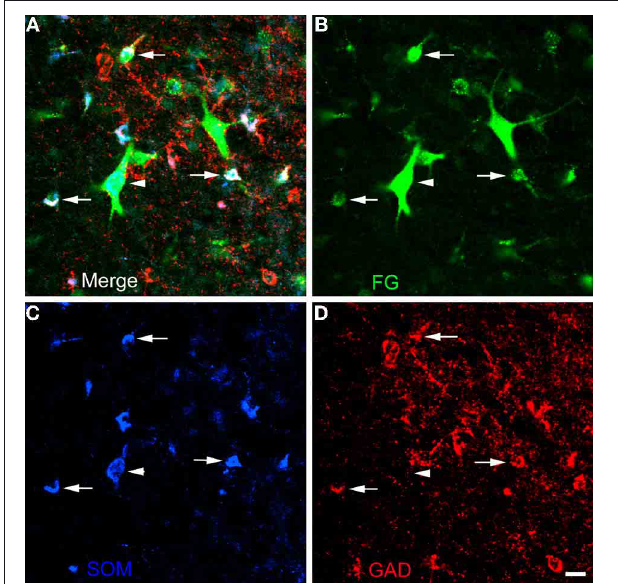
FIGURE 8 | Photomicrographsof neurons in the posterior subdivision of the basomedial nucleus (BMp) at bregma level-3.3 in a section triple-labeled for FG (green), SOM (blue), and GAD (red). (A) Merged image visualizing all three channels. Arrow indicates a neuron triple-labeled for FG/SOM/GAD + . Arrowhead indicates a SOM/GAD + neuron that is not retrogradely labeled with FG. The locations of the same neurons are indicated by identical arrows and arrowheads in B , C , and D . (B) Green channel image showing FG + neurons. (C) Blue channel image showing SOM + neurons. (D) Red channel image showing GAD + neurons. Scale bar in D = 20 µ m (also applies to A , B , and C ).